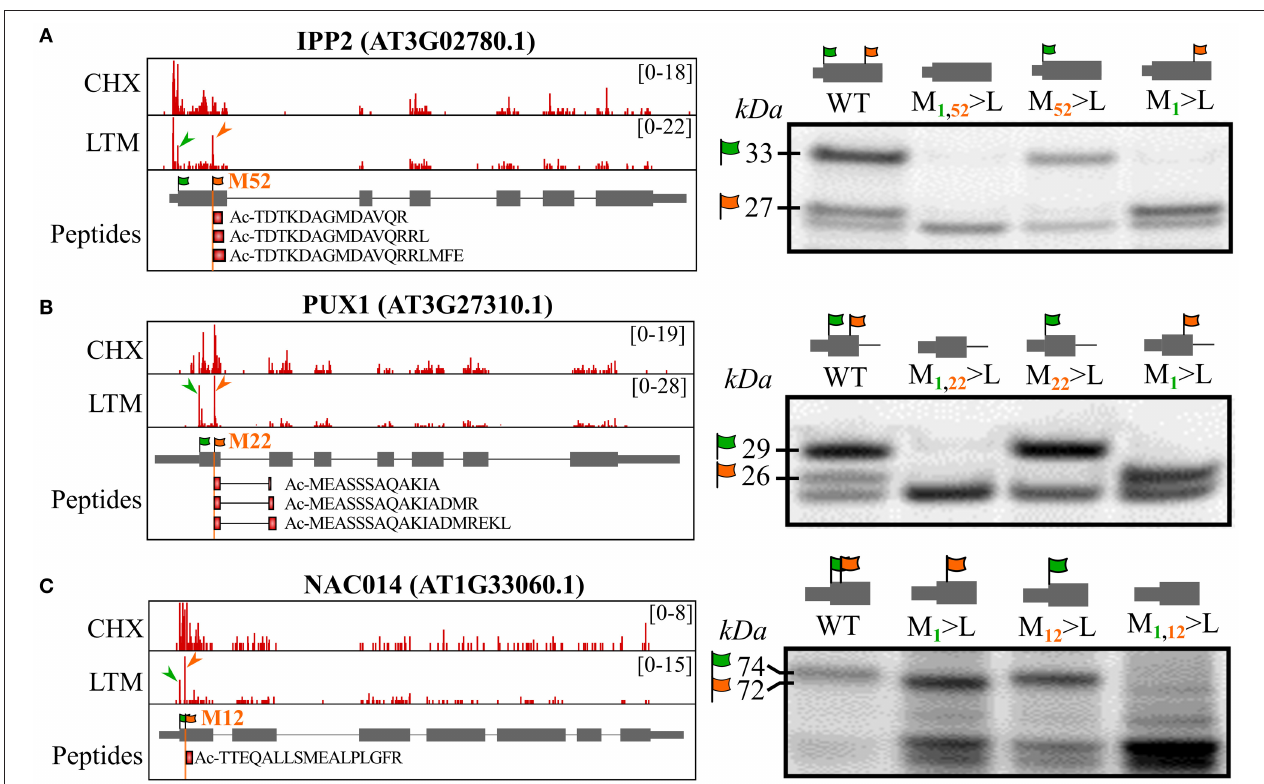
FIGURE 3 | In vitro coupled transcription and translation (TnT) of TIS-mutagenized expression constructs confirm translation of the by riboproteogenomics-identified Nt proteoforms. Control and TIS-mutagenized pUNI51 constructs encoding the identified Nt proteoforms of (A) ISOPENTENYL DIPHOSPHATE ISOMERASE2 ( IPP2 , AT3G02780), (B) plant UBX DOMAIN-CONTAINING PROTEIN1 ( PUX1 , AT3G27310), and (C) NAC DOMAIN-CONTAINING PROTEIN14 ( NAC014 , AT1G33060). (Left) Genome views showing CHX and LTM strand-specific positional Ribo-seq data (red). LTM peaks corresponding to Ribo-seq-called dbTIS and dTIS were indicated by green and orange arrowheads, respectively. The vertical orange line indicates the position of the riboproteogenomic-matched dTIS. Nt peptides matching the aTIS event were plotted as red rectangles. In the case of PUX1 , the Nt peptides span an exon-exon junction (right) (TIS mutagenized) Nt proteoform-encoding constructs were in vitro transcribed and translated. Following sodium dodecyl sulfate polyacrylamide gel electrophoresis (SDS-PAGE) and electroblotting, radiolabeled proteins were visualized by radiography. Assignments of the translation products corresponding to translation initiation at the TAIR10-annotated TIS (green flag, M1) and from the identified dTIS (orange flag) were verified by mutating their respective ATG start codons to the (near-cognate start) Leu-encoding codon TTG. In each case, theoretical molecular weights of the identified Nt proteoforms are